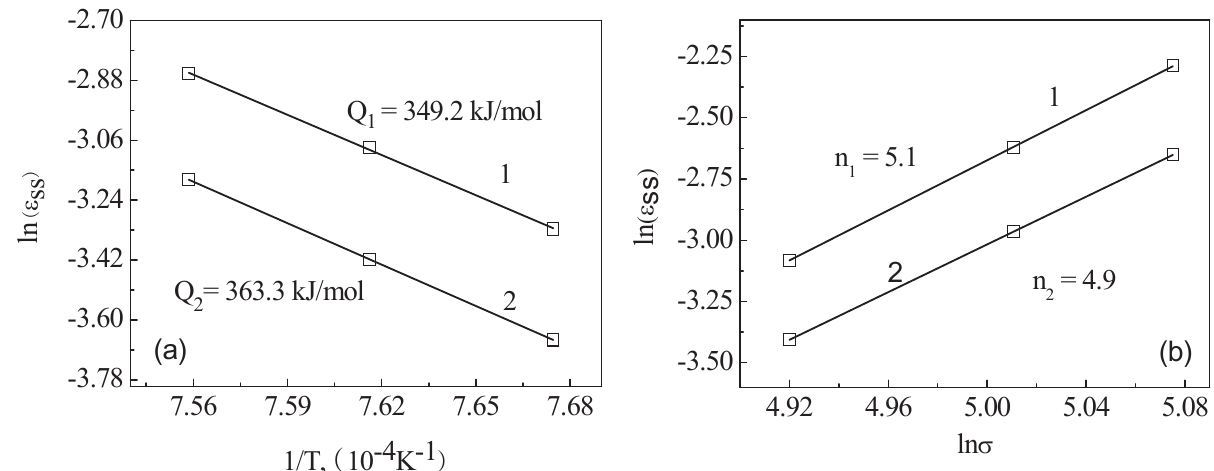
Figure 5. Relationships between the strain rates and applied temperatures, stresses during the steady state creep for the alloys 1 and 2. (a) Strain rate vs. temperatures at an applied stress of 137 MPa, (b) strain rate vs. applied stresses at a temperature of 1313 K.